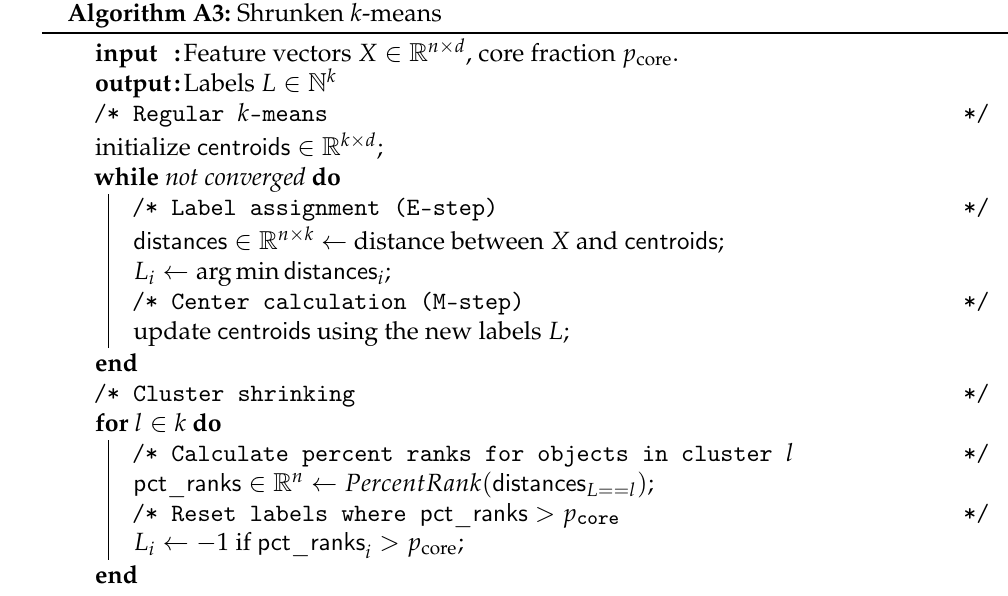
Algorithm A3: Shrunken k